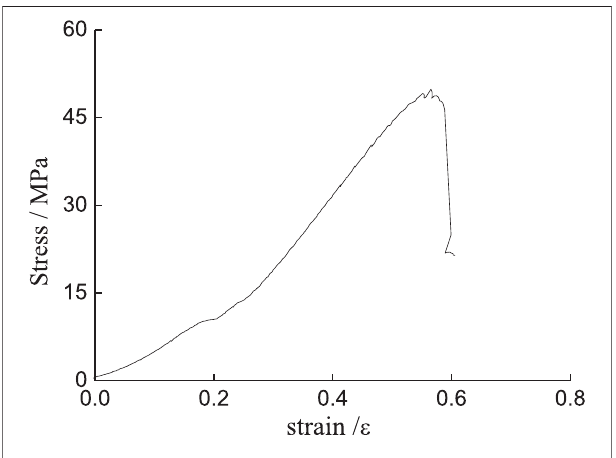
FIGURE 5 | Stress-strain curve of intact samples under uniaxial